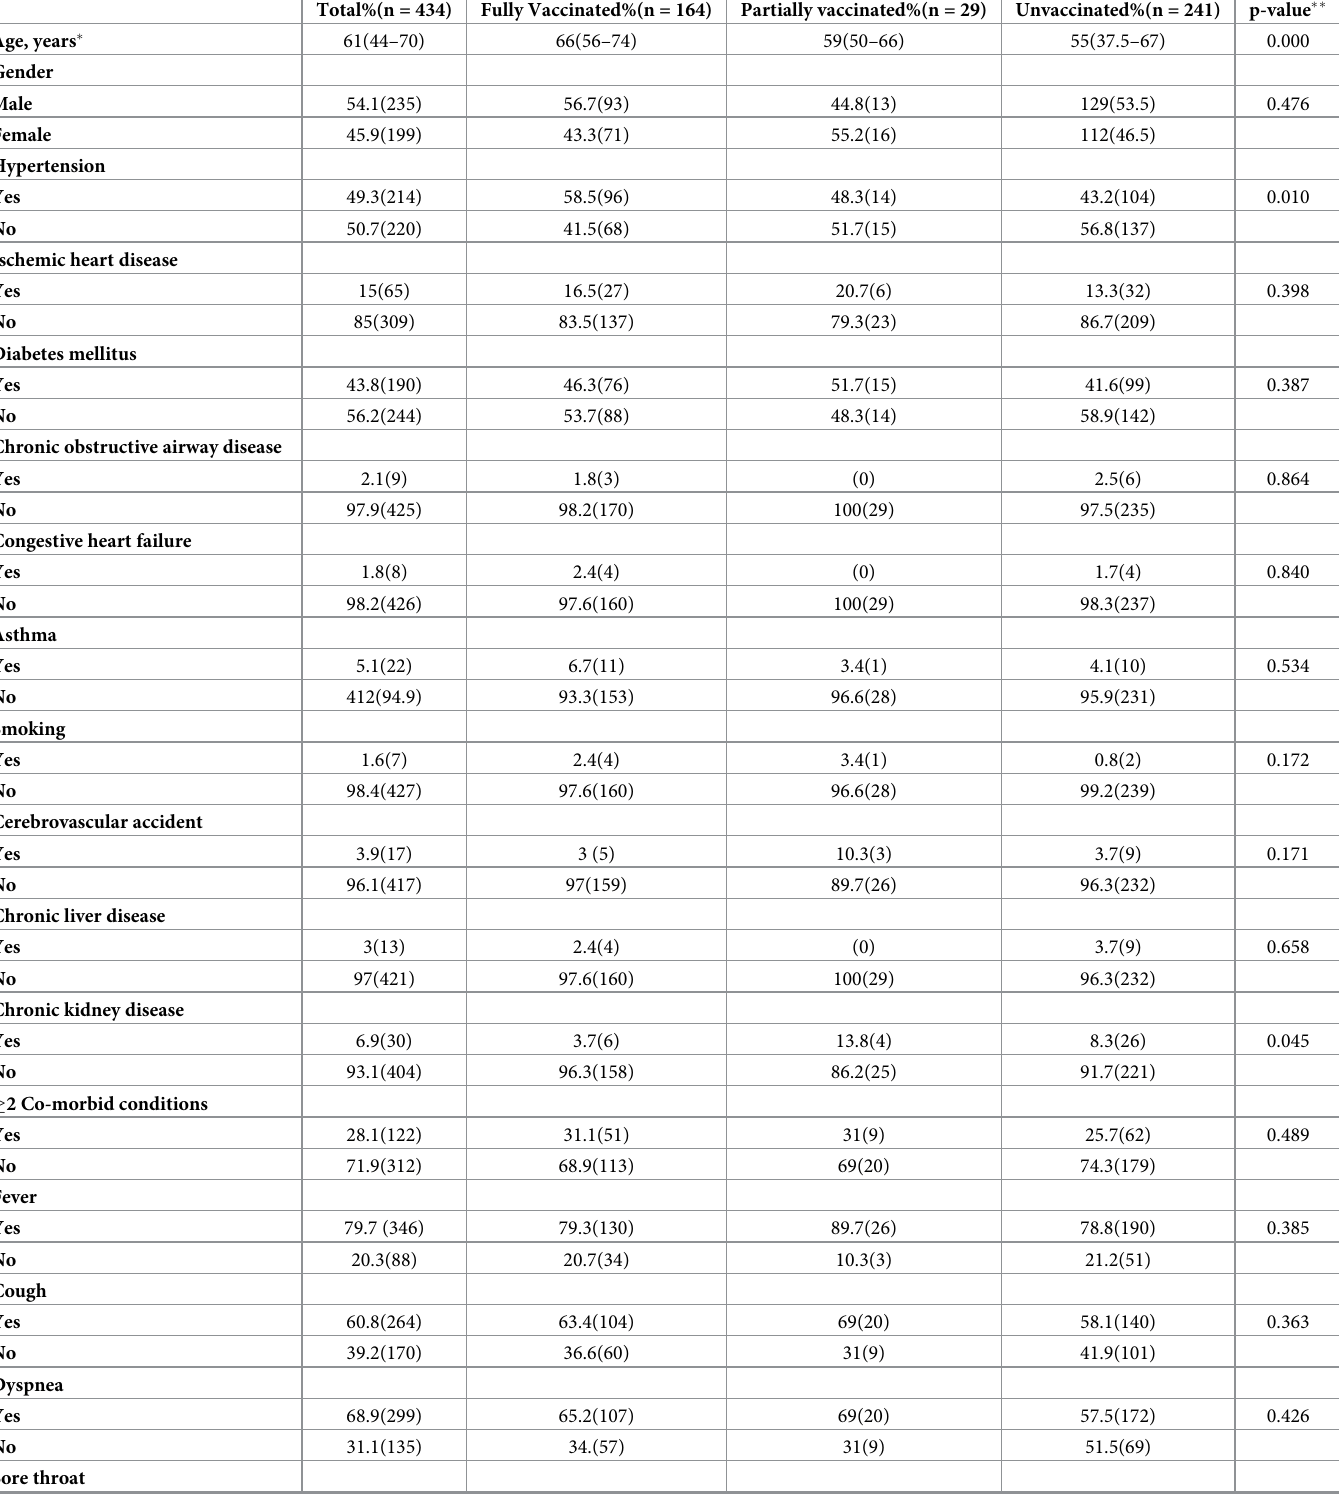
Table 1. The clinical characteristics of the study population (N =